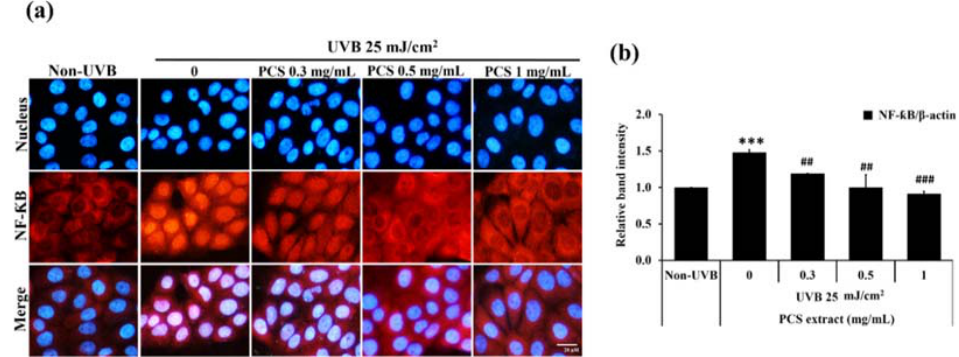
Figure 3. Protective effect of PCS extract on UVB-induced NF- κ B activity in HaCaT cells. After pre- treating cells with PCS extract for 1 h, cells were exposed to UVB, followed by incubation in fresh medium for 1 h. Then, cells were analyzed by immunofluorescence staining and Western blotting. ( a ) Images represent translocation of NF- κ B, AlexaFloure-546 (red color) indicates NF- κ B localiza- tion, and counterstain using Hoechst33342 (blue color) indicated nuclei. ( b ) The histogram presents the relative band intensity of NF- κ B protein expression after normalization with the internal control ( β -actin). Results were the average values ± SD ( n = 3). *** p < 0.001 vs. non-UVB group and ## p < 0.01; ### p < 0.001 vs. the UVB control group.